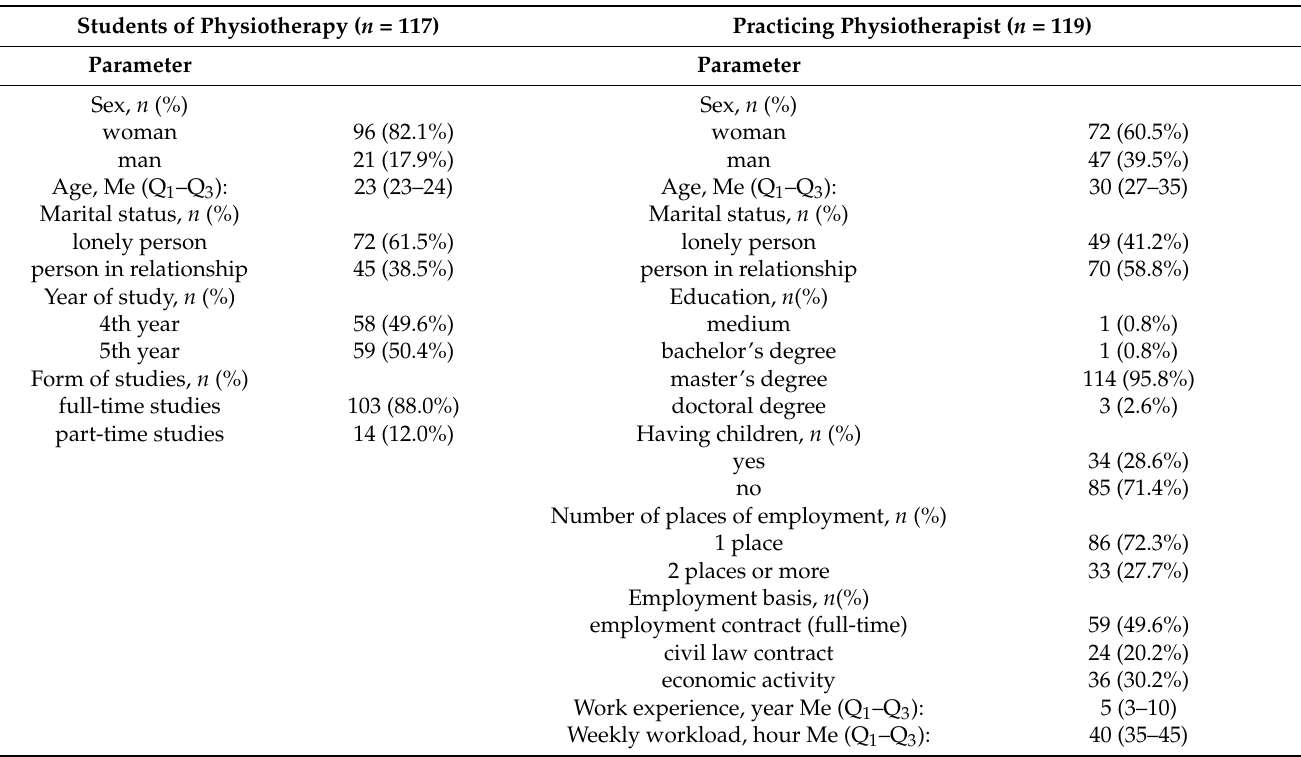
Table 1. Characteristics of the physiotherapy students and practicing physiotherapists. Practicing Physiotherapist ( n =